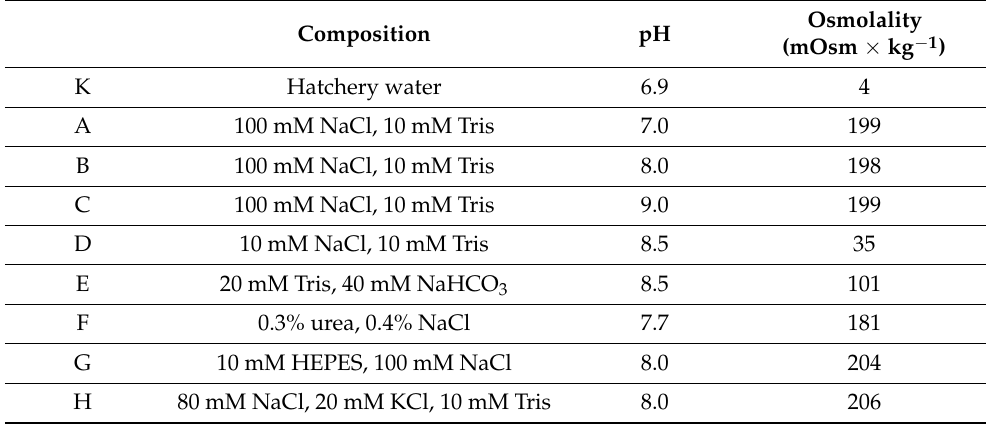
Table 1. Composition of the buffers used during the determination of the optimal activating solution for perch sperm motility parameters and fertilisation. Composition pH